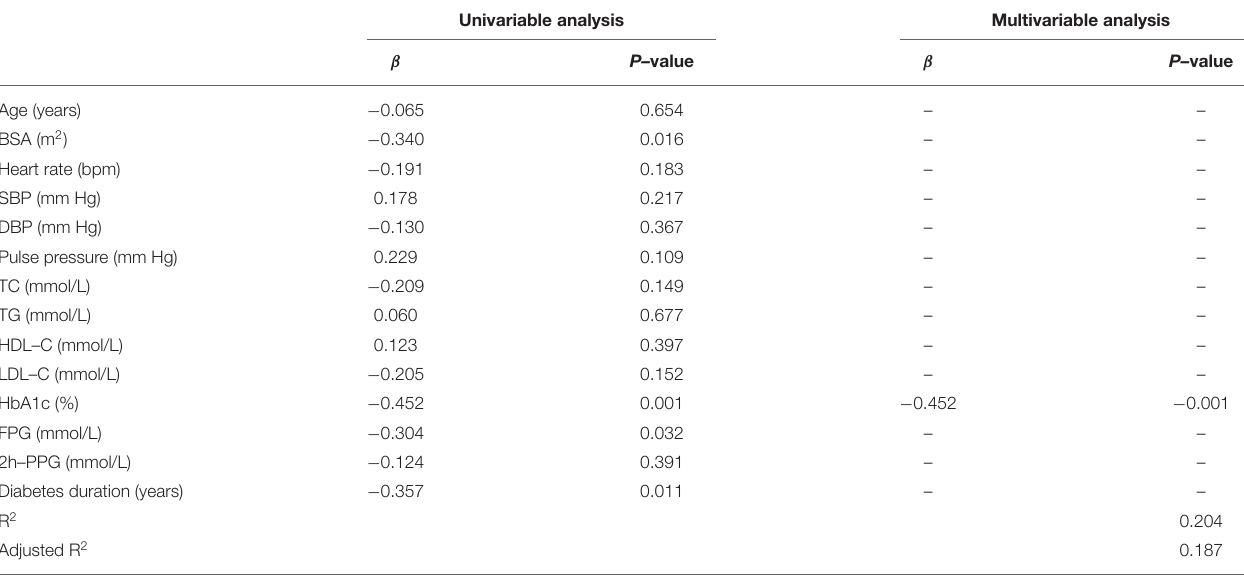
TABLE 4 | Univariable and multivariable linear regression analysis of GWI in T2DM